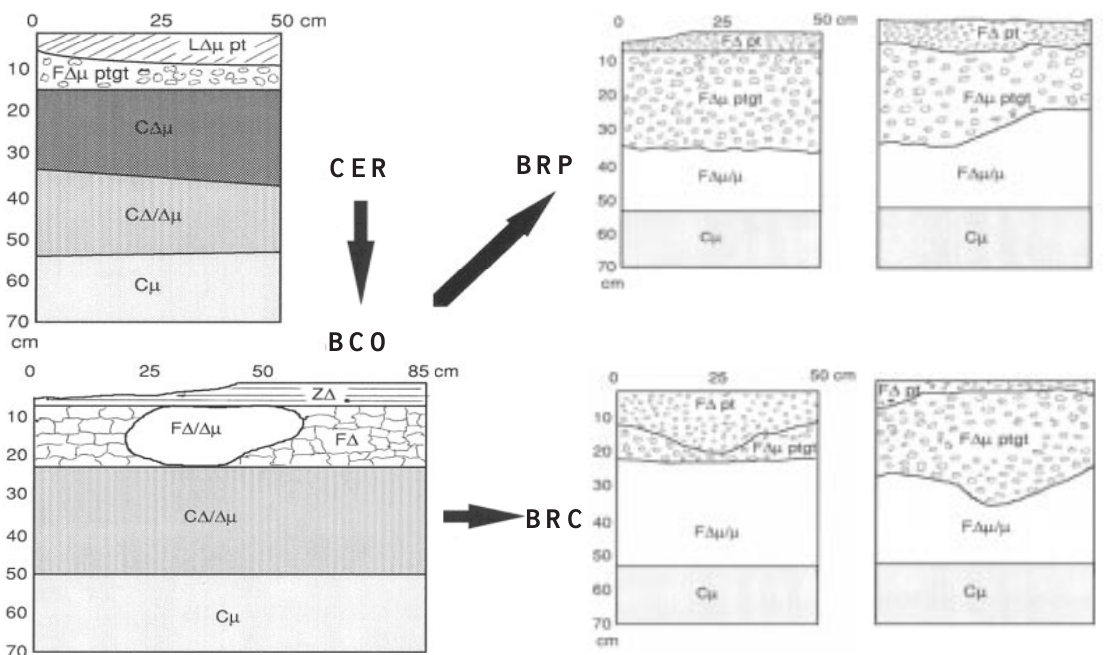
Figura 1. Esquema dos perfis culturais, indicando as modificações nos tratamentos aplicados nas diferentes